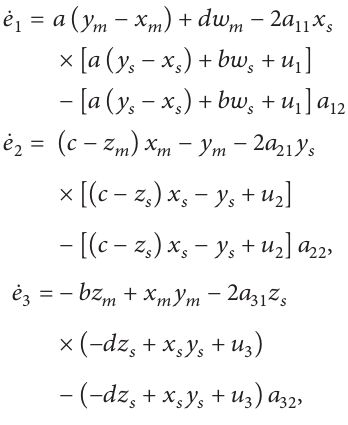
𝑧 2 (the solid line). (d) Signals